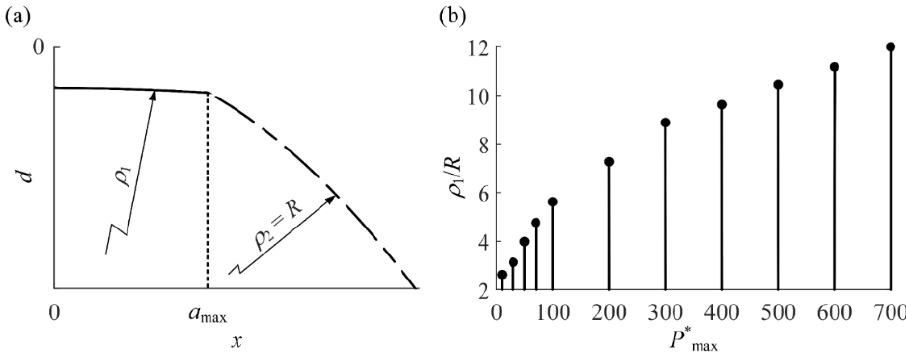
Figure 10. ( a ) An example of deformed sphere surface after unloading and ( b ) the dimensionless residual radius of curvature of the sphere surface within A max after unloading for different P * max .